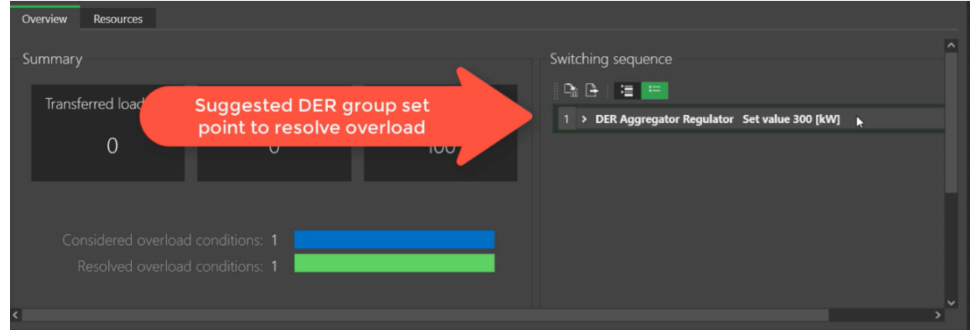
Figure 5. Overload resolution through the EcoStruxure